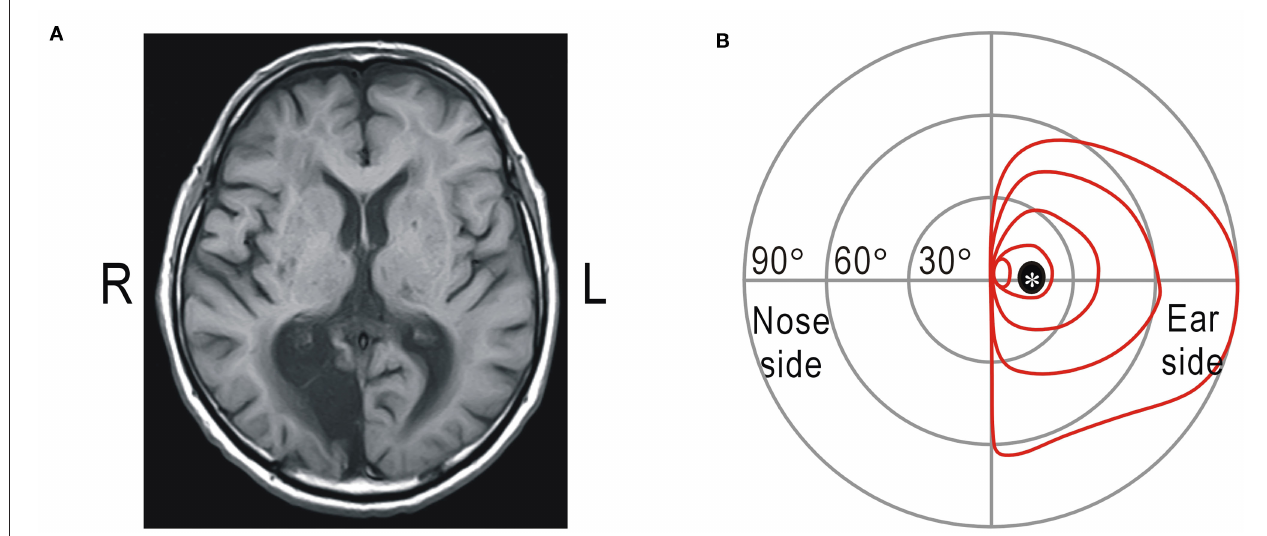
FIGURE 2 | (A) Magnetic resonance imaging of the brain. Cerebral infarction noted in the right occipital lobe including the visual cortex (R: right; L: left). (B) Results of Goldmann perimetry of the right eye. *Mariotte blind spot.